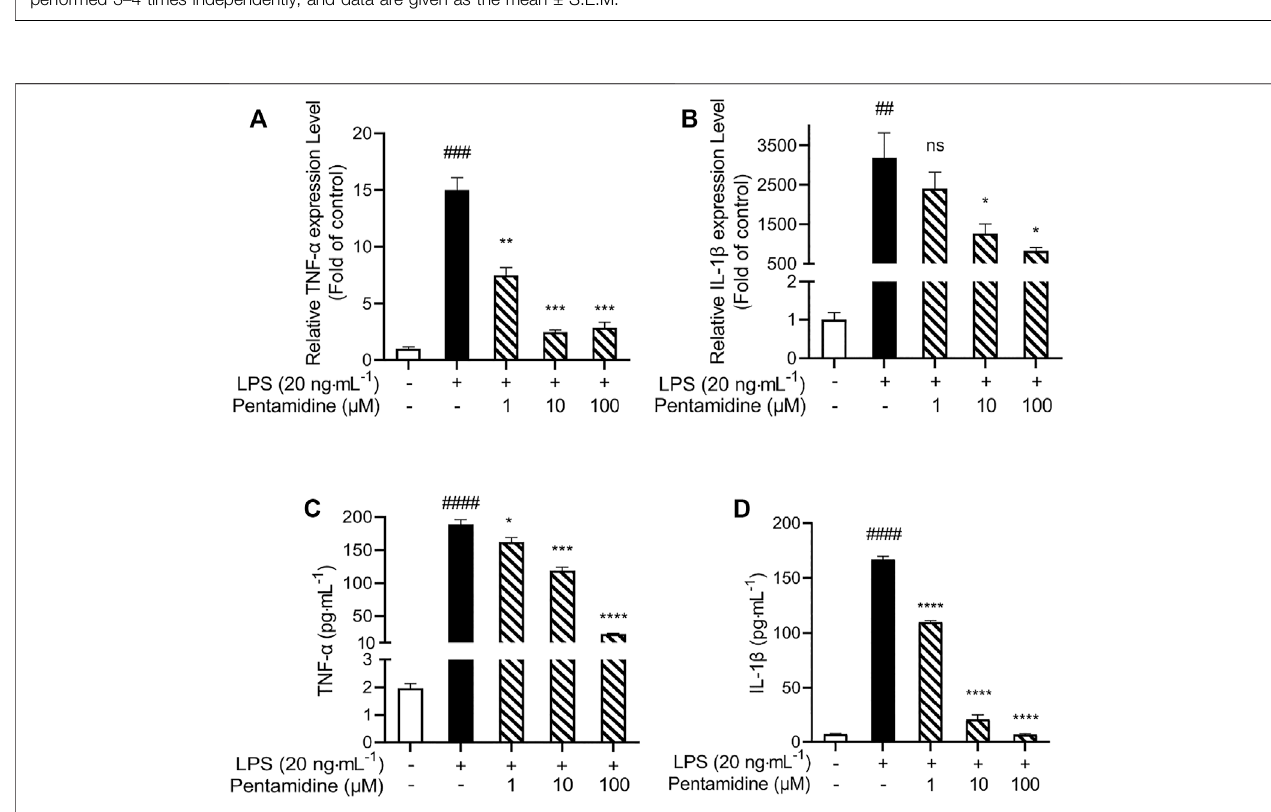
FIGURE 6 | Pentamidine inhibits LPS-induced pro-in fl ammatory factors TNF- α (A,C) and IL-1 β (B,D) at mRNAs (A,B) and protein (C,D) level overproduction. RAW264.7 cells were treated with 20 ng ml − 1 LPS and indicated concentrations of pentamidine for 24 h. Total RNA was extracted and qRT-PCR was performed to measure the expression of TNF- α and IL-1 β mRNAs. The TNF- α and IL-1 β proteins in the supernatant were measured by ELISA according to the manufacturer ’ s instructions. All experiments wereperformedthree times independently, anddata weregivenasthemean ±S.E.M. ##, p < 0.01versusthecontrol; ###, p < 0.001 versusthecontrol;####, p < 0.0001versusthecontrol;*, p < 0.05versustheLPSgroup;**, p < 0.01versustheLPSgroup;***, p < 0.001versustheLPSgroup;****, p < 0.0001 versus the LPS group; ns, not signi fi cant.